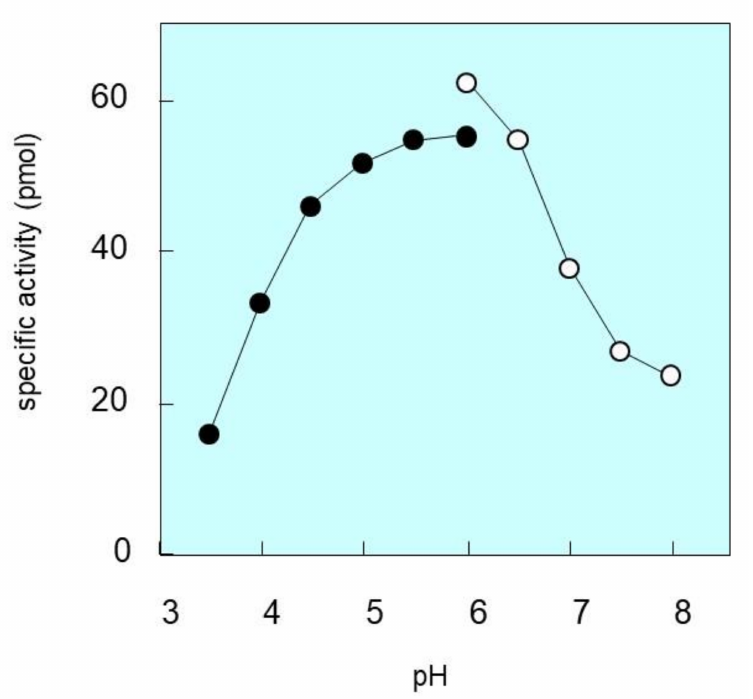
Figure 6. pH dependence of SM deacylase activity. SM deacylase activity of the purified and reduced enzyme was measured at the indicated pHs by examining the amount of SPC released. The pH value was adjusted using the following bu ff ers: 50 mM potassium acetate (closed circles) or 50 mM sodium phosphate (open circles). In addition to those pH bu ff ers, the enzyme reactions were performed by adding 20 mM CaCl 2 , 200 µ M SM and 0.1% Triton